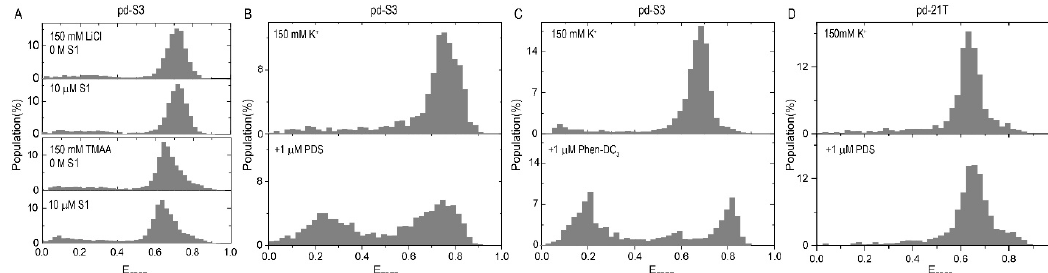
Figure 2. ( A ) Even in the presence of 10 µ M S1, no shift in the FRET was observed for the pd-S3 construct in the 150 mM LiCl (top) or 150 mM TMAA (bottom), suggesting the shift in KCl to be due to the i-GQ formation. ( B ) Demonstration of the change in the FRET histogram upon adding 1 μ M PDS. A significant low FRET population emerged which was considered to be due to the interaction of PDS with the fluorophores. ( C ) Similar low FRET states were observed when 1 μ M Phen-DC 3 was introduced. ( D ) Such low FRET states were not observed when PDS was introduced in a chamber that contained pd-21T construct, an unstructured DNA (polythymidine) of similar length to pd-S3 .